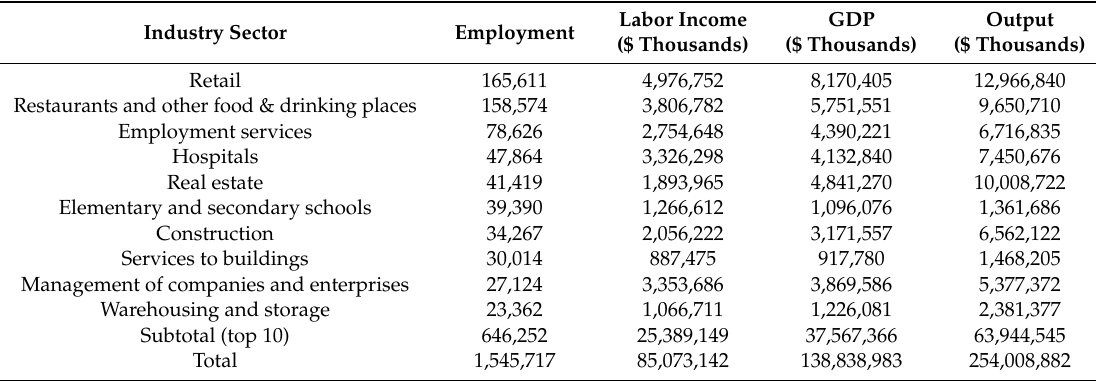
Table 7. Top 10 Most A ff ected Sectors by